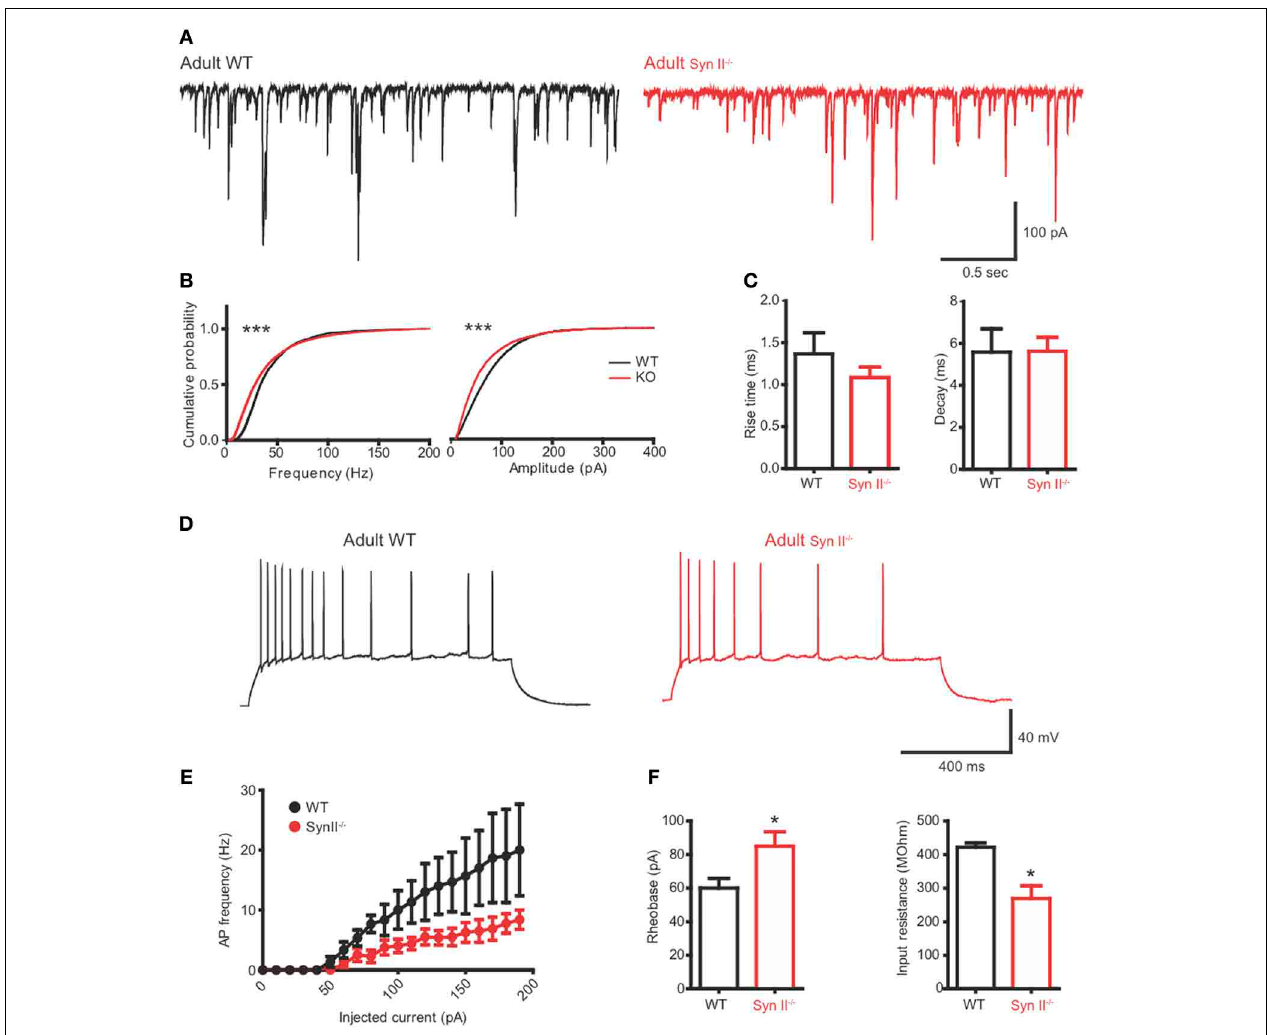
FIGURE 6 | The hilar mossy cell phenotype of pre-symptomatic Syn II − / − mice is maintained in adult symptomatic Syn II − / − mice. (A) Representative mEPSC traces (A) and cumulative distributions (B) of their amplitude and frequency from 4 to 6 months old WT (black) and Syn II − / − (red) mossy cells; ∗∗∗ p < 0 . 001, Kolmogorov–Smirnov test. (C) Mean ( ± s.e.m.) rise-time (10–90%) and mono-exponential τ of decay of mEPSCs